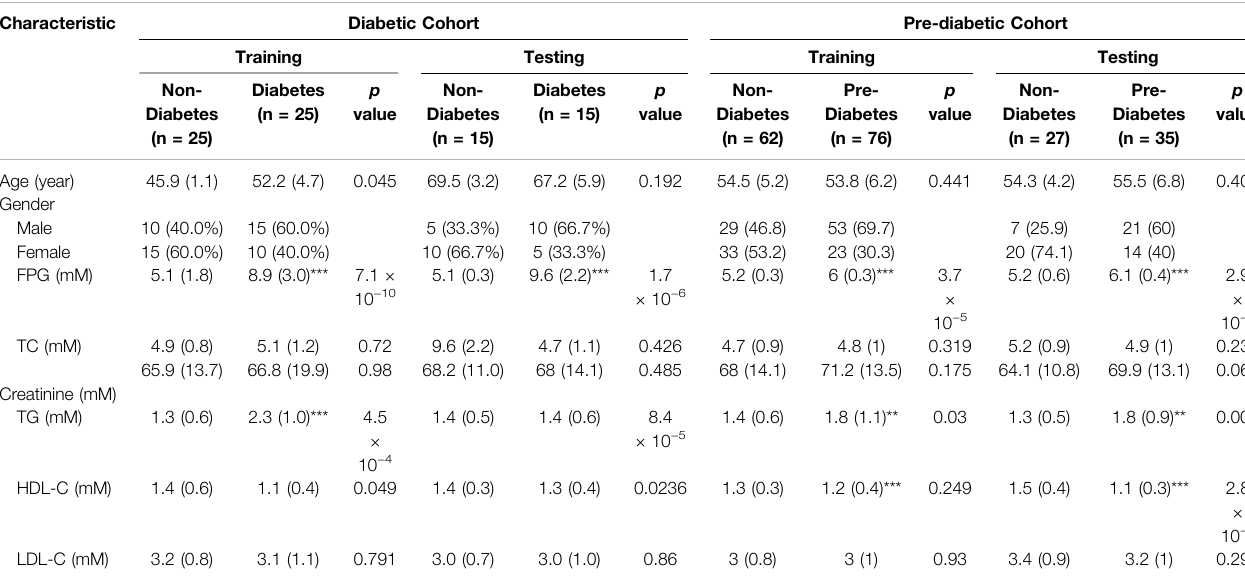
TABLE 1 | Demographic